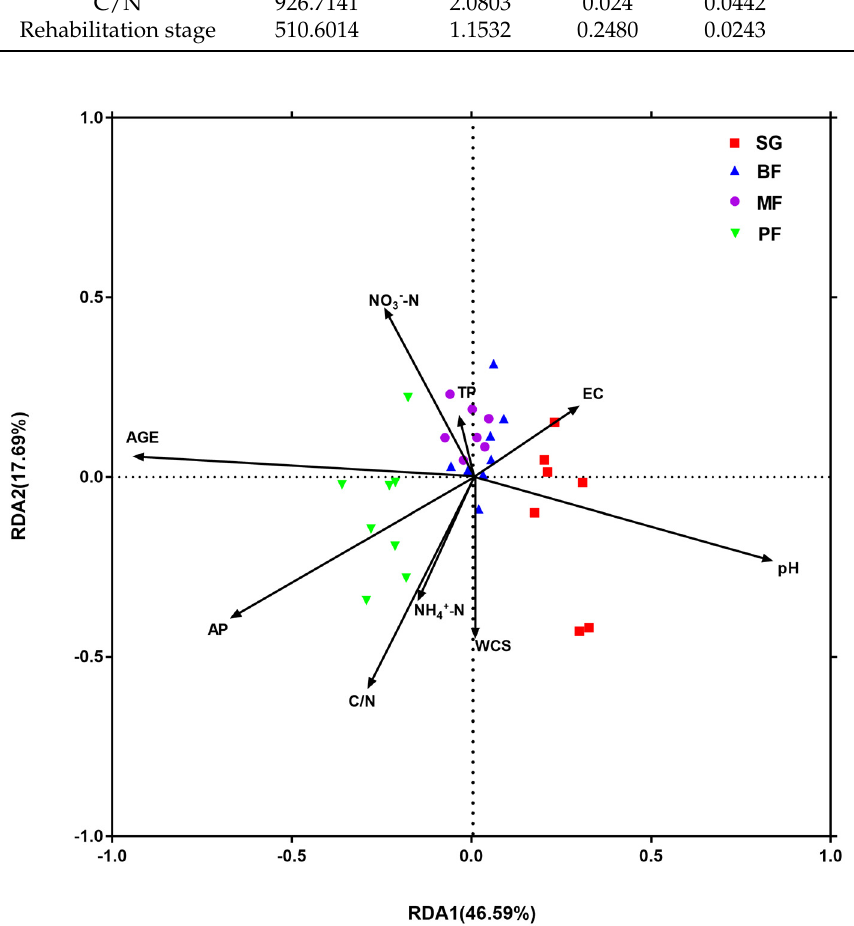
Figure 4. Redundancy analysis (RDA) showing the effects of environmental variables on the bacterial communities among the four succession stages. SG: Shrub-grassland; BF: Broad-leaved; MF: Coniferous broad-leaved; PF: Primary forest. pH, soil pH; EC, electrical conductivity; NH 4+ -N, Ammonium; NO 3- -N, nitrate; TP, total phosphorus; AP, available phosphorus; WCS, soil water content; AGE, rehabilitation age; C/N, soil C/N ratio.